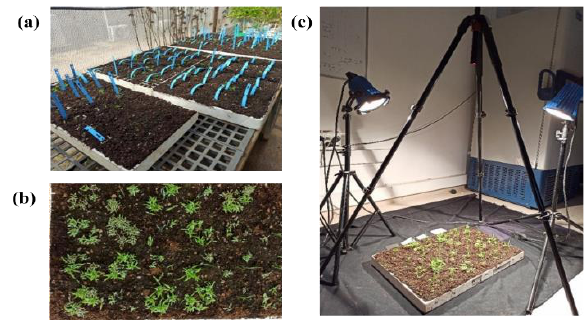
Figure 1 Experimental setup. (a) The trays with three different weed species were grown in a net house. (b) An example for one of the trays. (c) images were acquired using a hyperspectral camera in a semi-dark room, illuminating the scene with two halogen lamps. grouping methods. (a) RGB visualization of the hyperspectral image, (b), (c), and (d) ground truth data for plant species, botanical groups, and photosynthesis mechanisms, respectively.